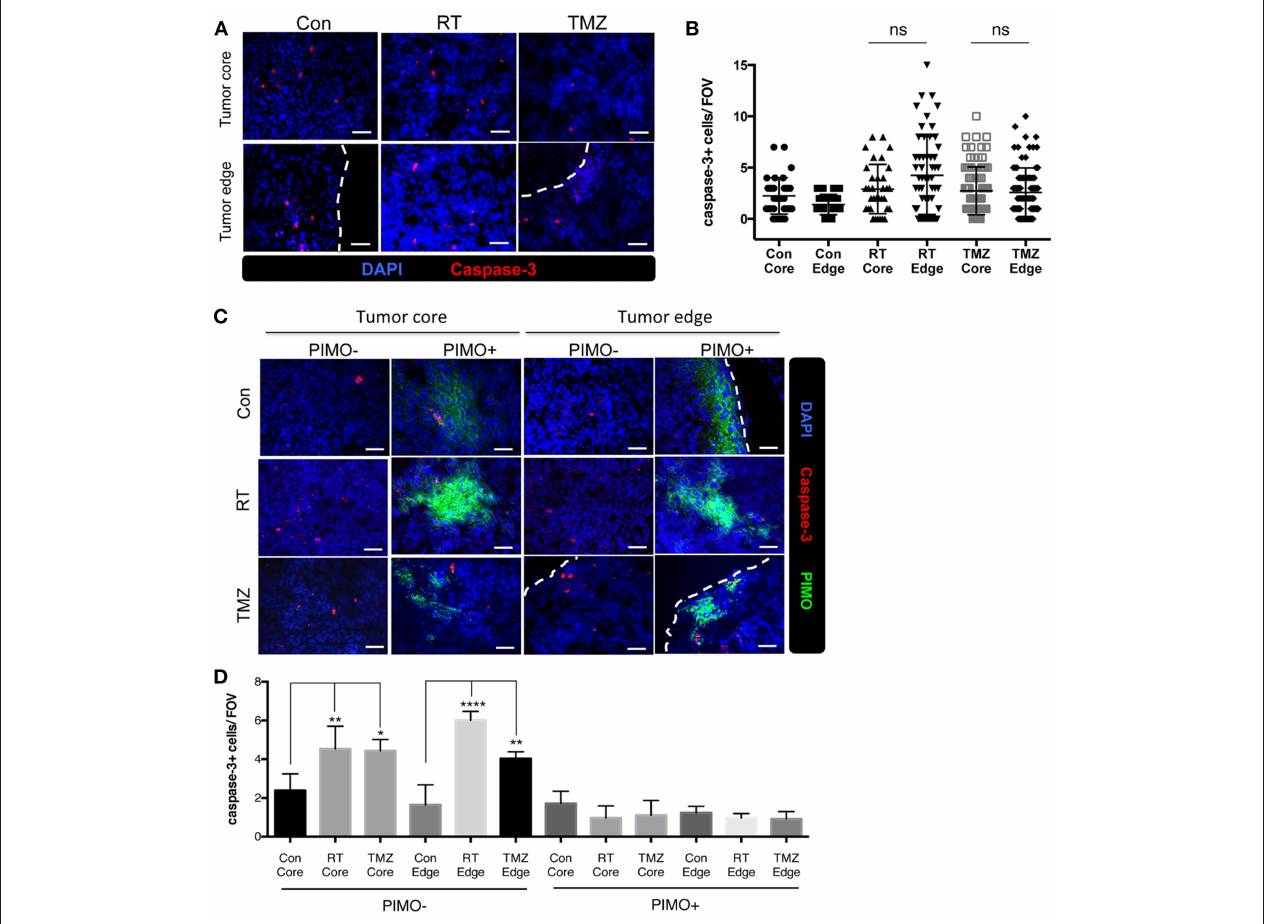
FIGURE 8 | Transient peripheral hypoxia caused brain tumor cells escape from the cytotoxicity of radiation or chemotherapy. (A) Representative images of caspase-3 staining. Apoptotic cells were detected by IHC staining for caspase-3 (red) in control, irradiated, or TMZ-treated ALTS1C1 tumors. Nucleus staining with DAPI was shown in blue. (B) Caspase-3 + cells at tumor core and edge of each group was quantified. n > 33 fields per tumor of total 3 tumors in each group. (C) Representative figures of apoptotic cells in hypoxic or non-hypoxic region of tumors treated with irradiation or TMZ. Sections were double IHC staining for caspase-3 (red) and PIMO (green) in control, irradiated, or TMZ-treated ALTS1C1 tumors. Nucleus staining with DAPI was shown in blue. (D) The number of caspase-3 + cell in hypoxic or non-hypoxic region of tumors was quantified. Each group had at least three mice for data analysis. All data points were analyzed in triplicate and values displayed are means ± SDs. The significant difference of treatment groups was compared with control group and analyzed by ANOVA. ns: P > 0.05, * P < 0.05, ** P < 0.01, **** P < 0.0001. Scale bar = 50 µ